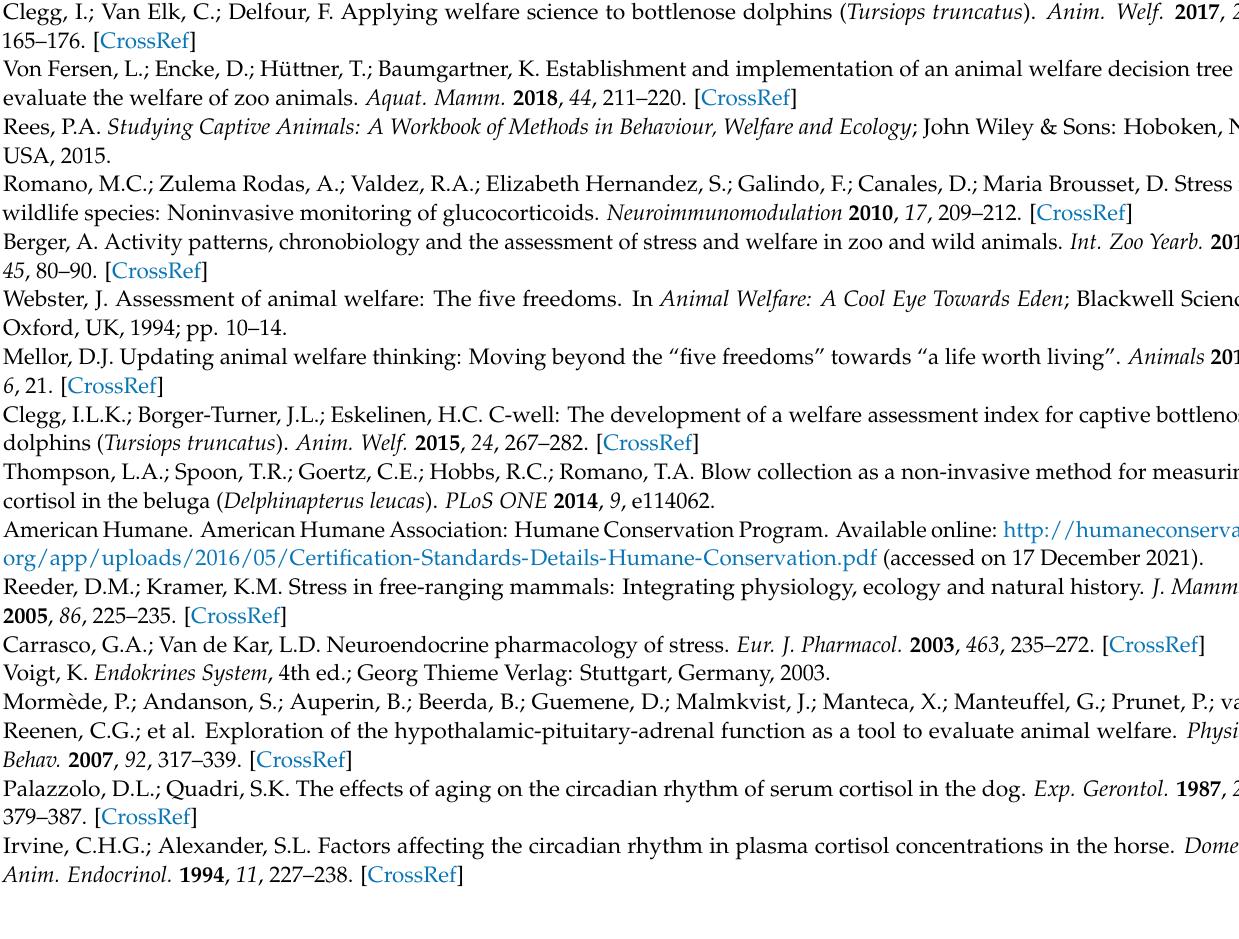
Figure A4. Correlation between blood cortisol values and saliva values during restriction. An exponential curve was fitted. Saliva samples were taken before (green dots) and after (red dots) the blood samples; see Figure 3 for an exemplarily sampling scheme. Three dolphins were sampled (Jenny = 9 samples; Moby = 1 sample; Anke = 1 sample; Nami = 2 samples before, 3 samples after).